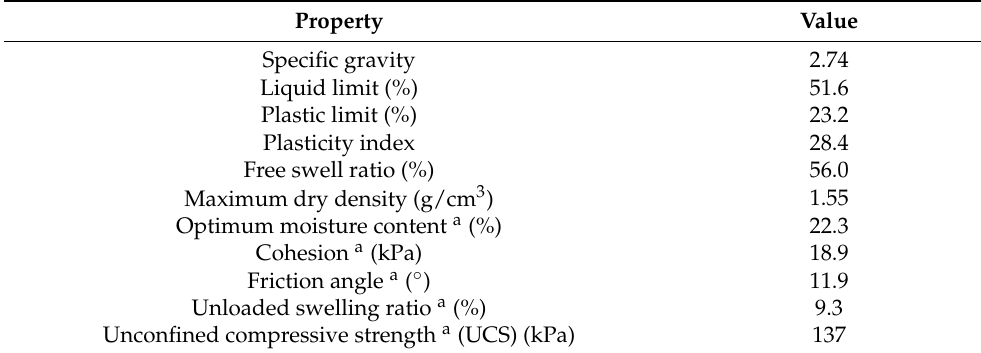
Table 1. Engineering properties of the expansive soil used in the